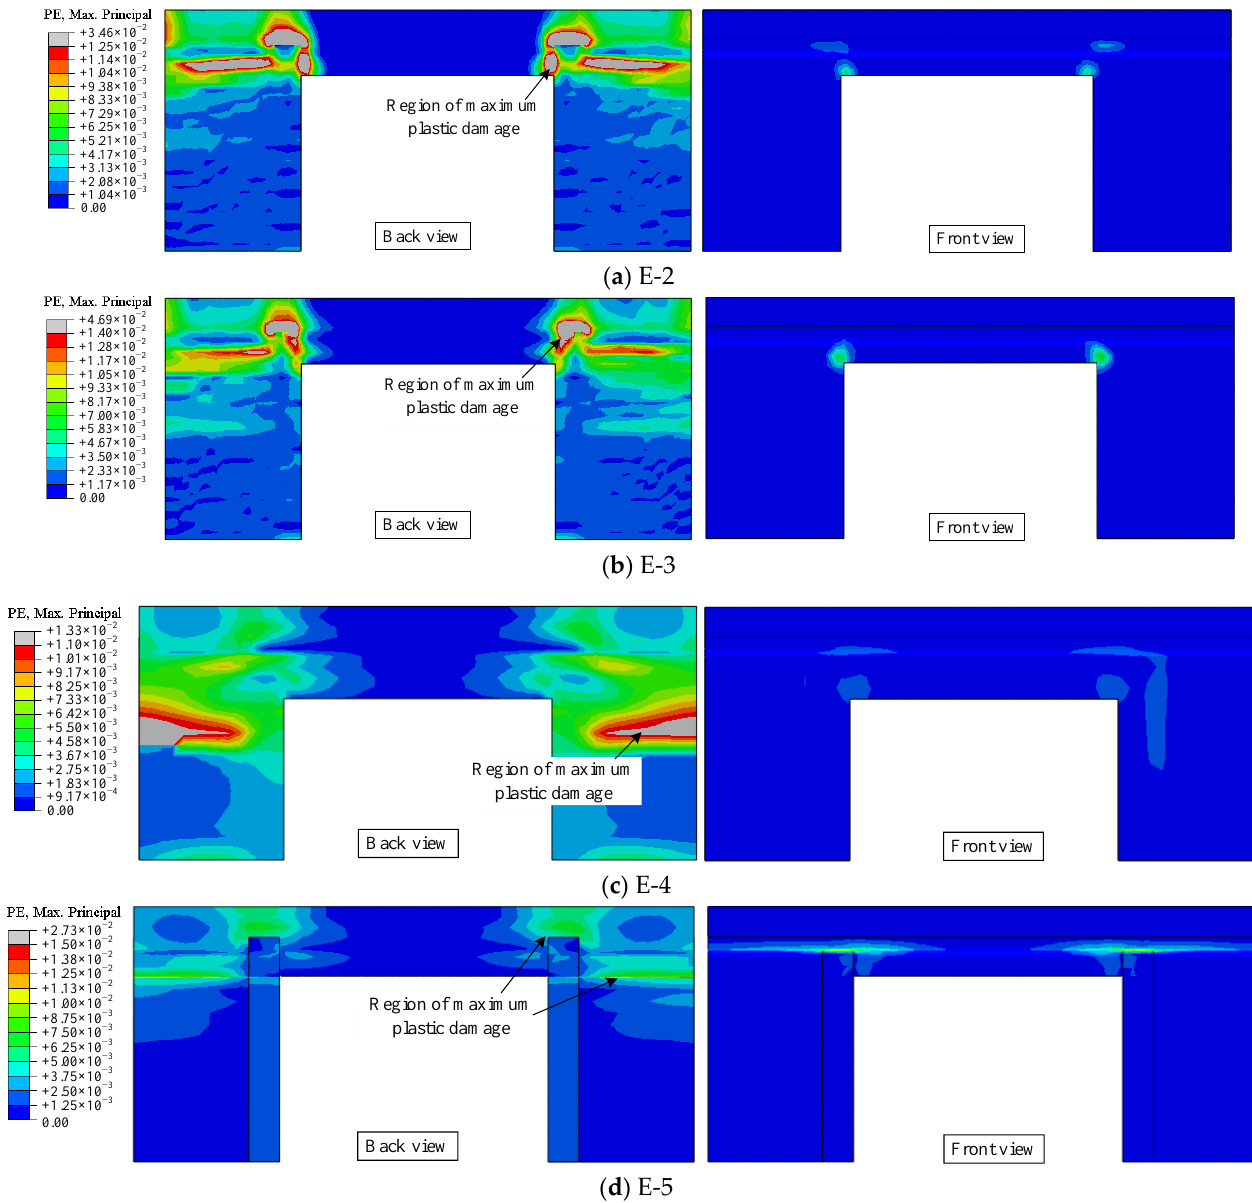
Figure 20. Maximum principal inelastic strain patterns of the concrete for Cases E-2 to